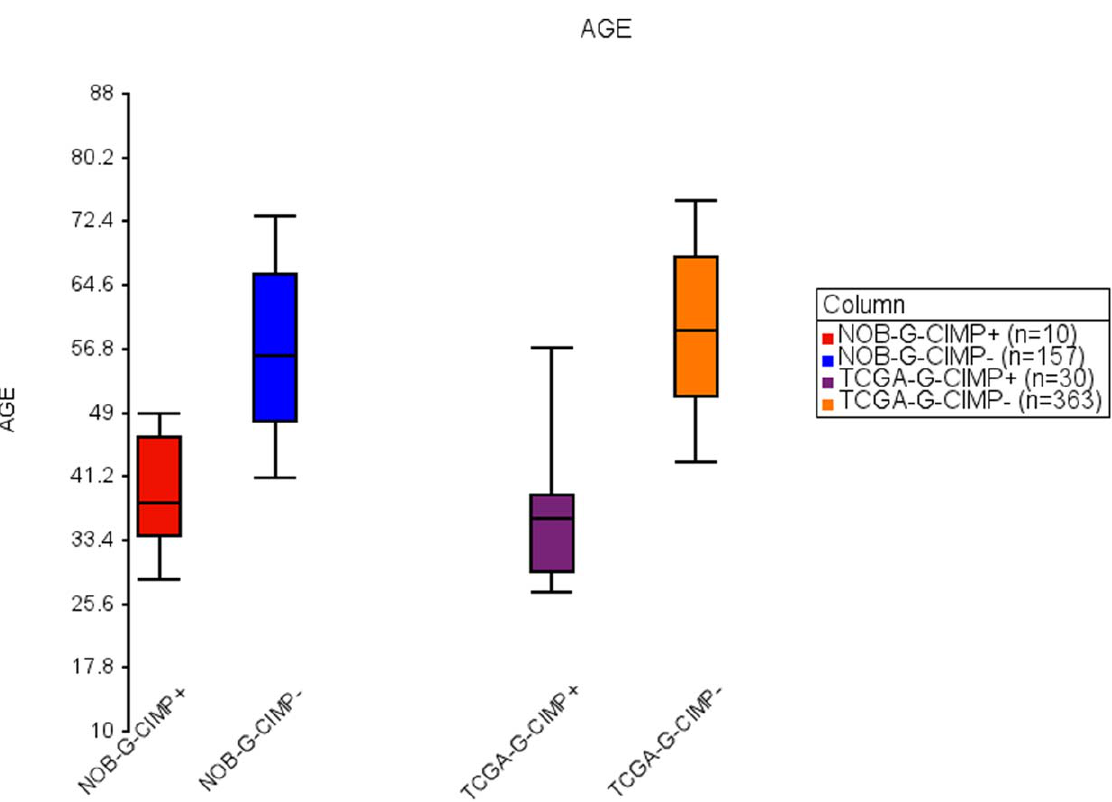
Figure 4. Box-Whisker plot of age of NOB and TCGA G-CIMP positive and G-CIMP negative samples. Limits of box and whiskers plot are 10%, 25%, 50%, 75% and 90%.